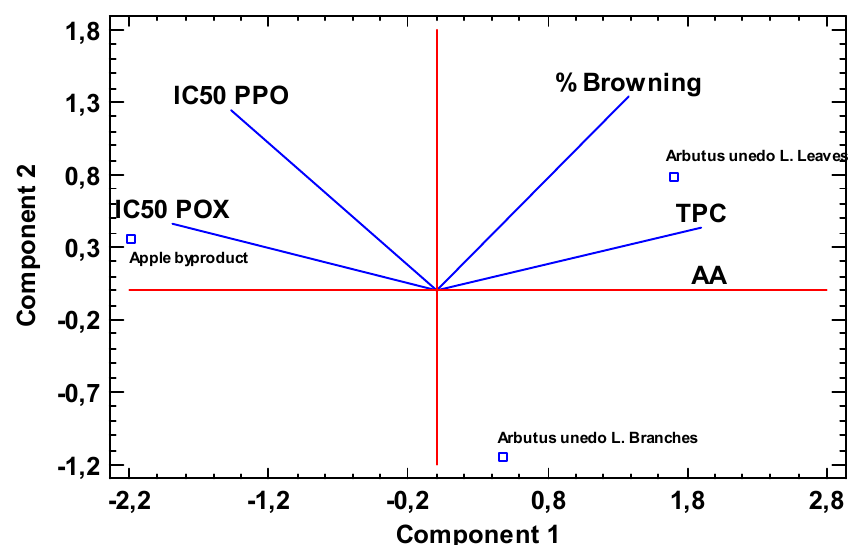
Figure 3. PCA analysis for % Browning, TPC, AA, IC50 PPO, and IC50 POX. The first component explained 79.24% of the variance across the extracts and the second component explained 20.77% of the variance.